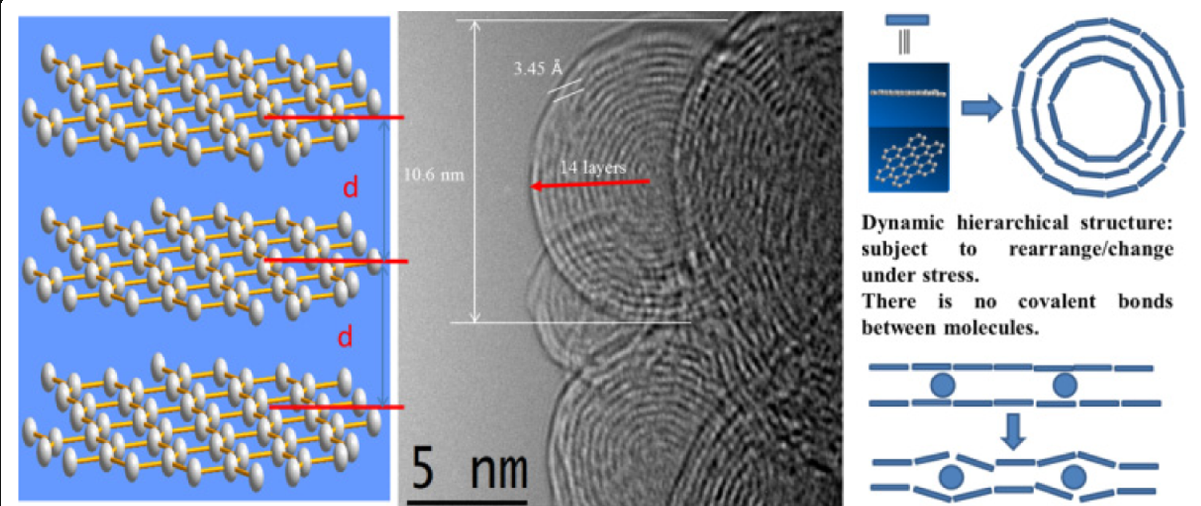
Fig. 2 Nano-graphene dynamic hierarchical assemble to rearrange and